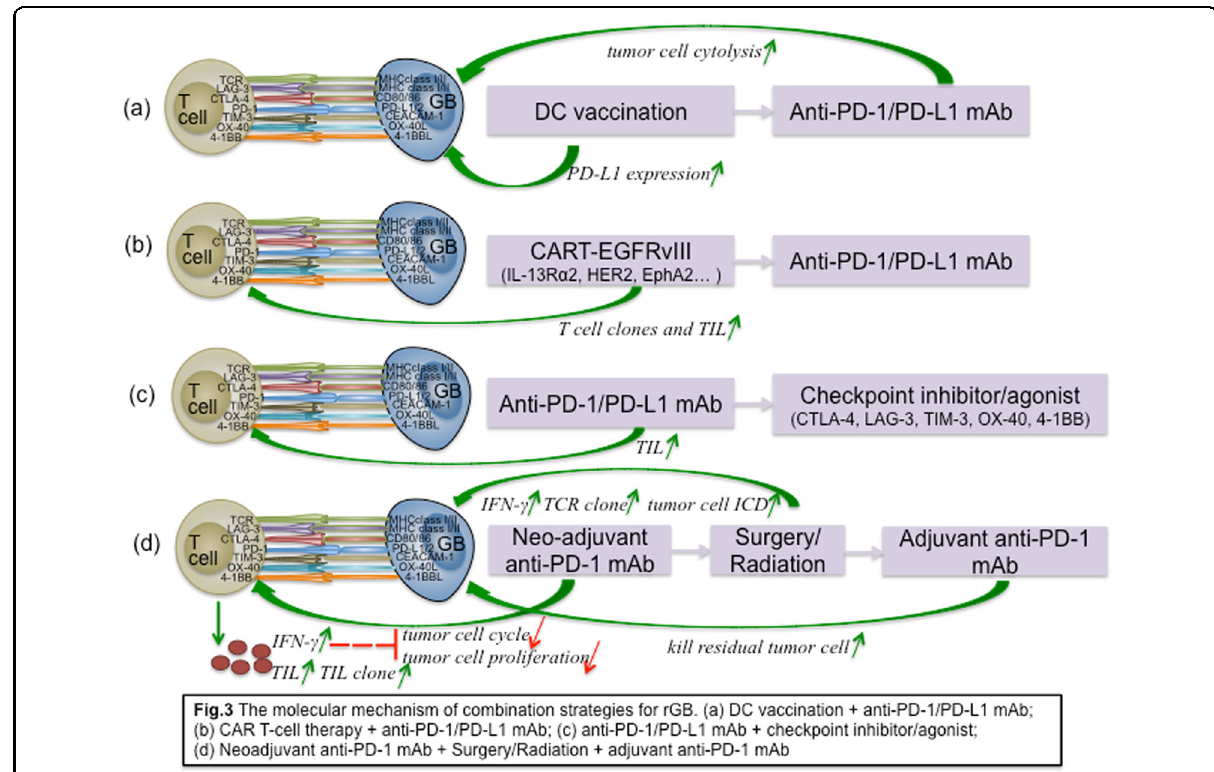
Fig. 3 The molecular mechanism of combination strategies for rGB. a DC vaccination + anti-PD-1/PD-L1 mAb; b CAR T-cell therapy + anti-PD-1/ PD-L1 mAb; c anti-PD-1/PD-L1 mAb + checkpoint inhibitor/agonist; d Neoadjuvant anti-PD-1 mAb + surgery/radiation + adjuvant anti-PD-1